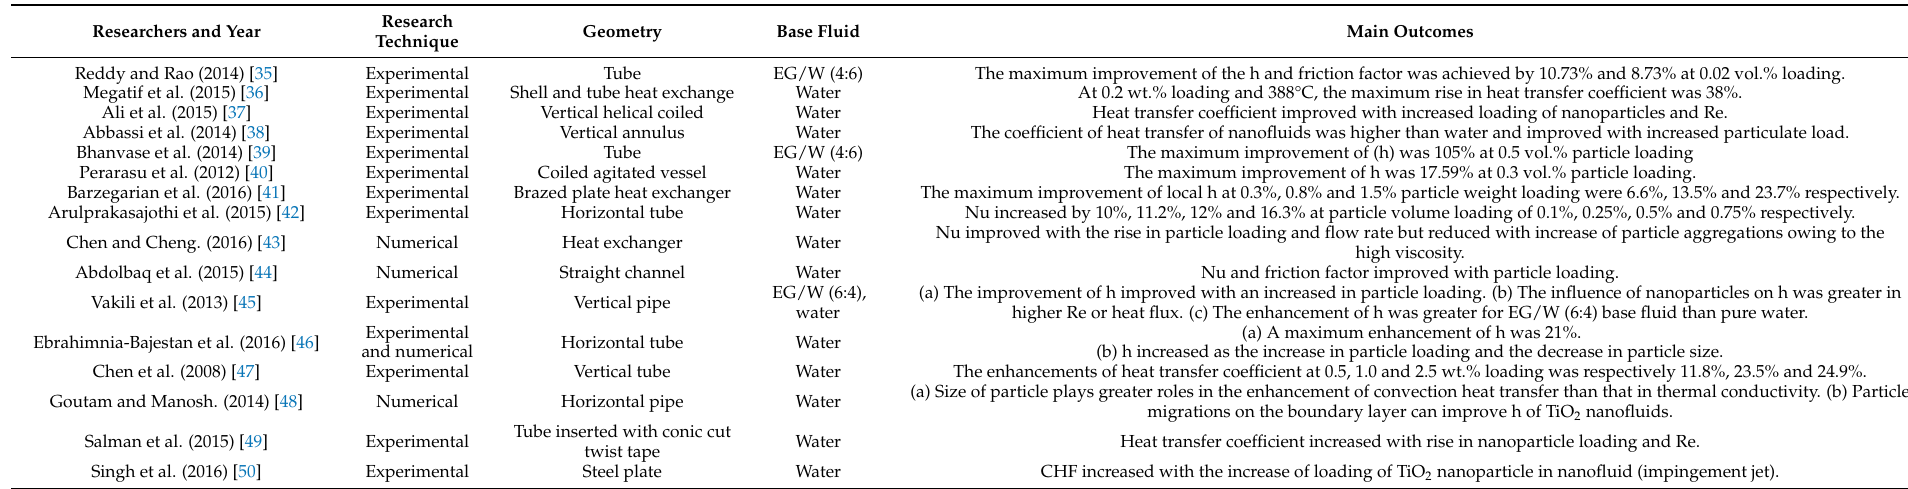
Table 6. Comparison of convective heat transfer in Nano particle applications.